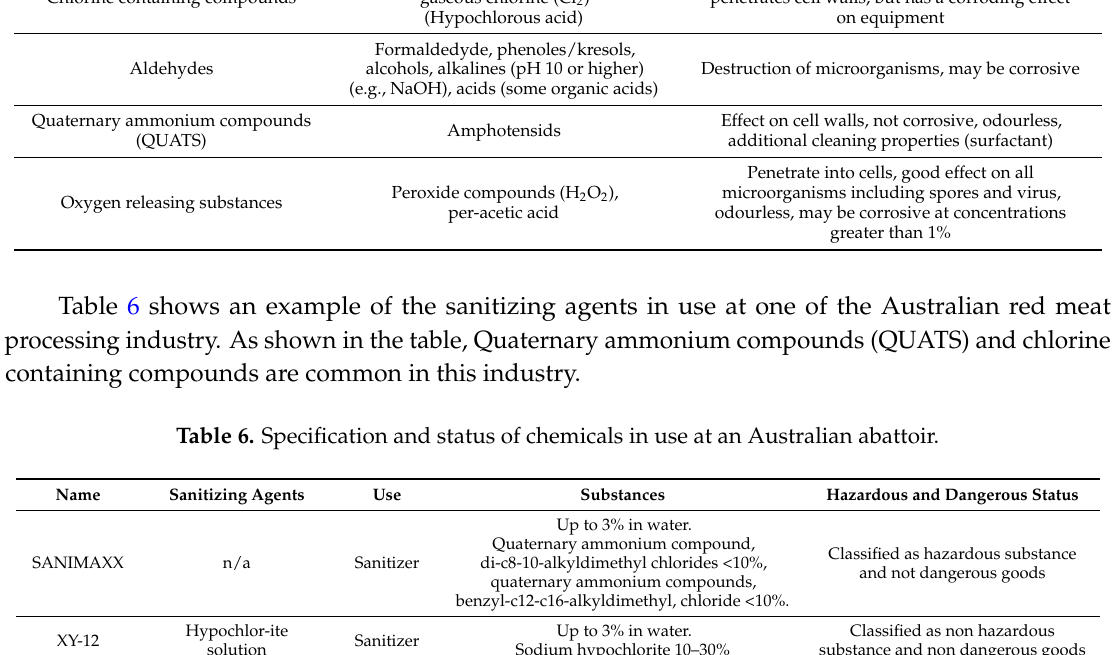
Table 6. Specification and status of chemicals in use at an Australian abattoir.